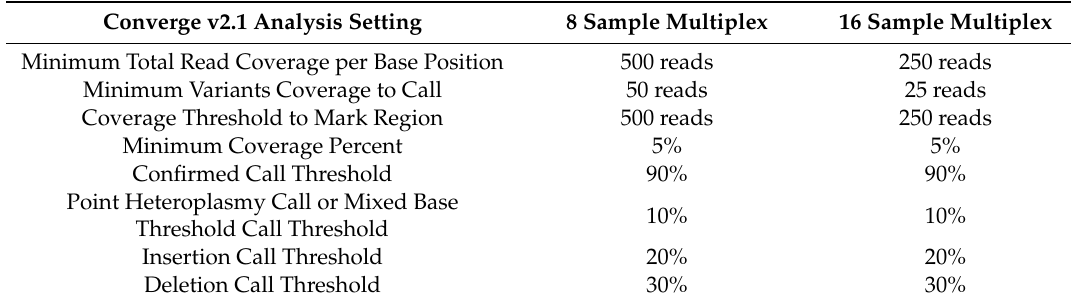
Table 2. Converge ™ v2.1 analysis settings for sequencing runs of 8 and 16 samples. For the minimum coverage percent, the threshold is relative to the median number of reads for the amplicon of interest. The confirmed, point heteroplasmy, insertion and deletion percentage thresholds are related to the total number of reads for the base position of